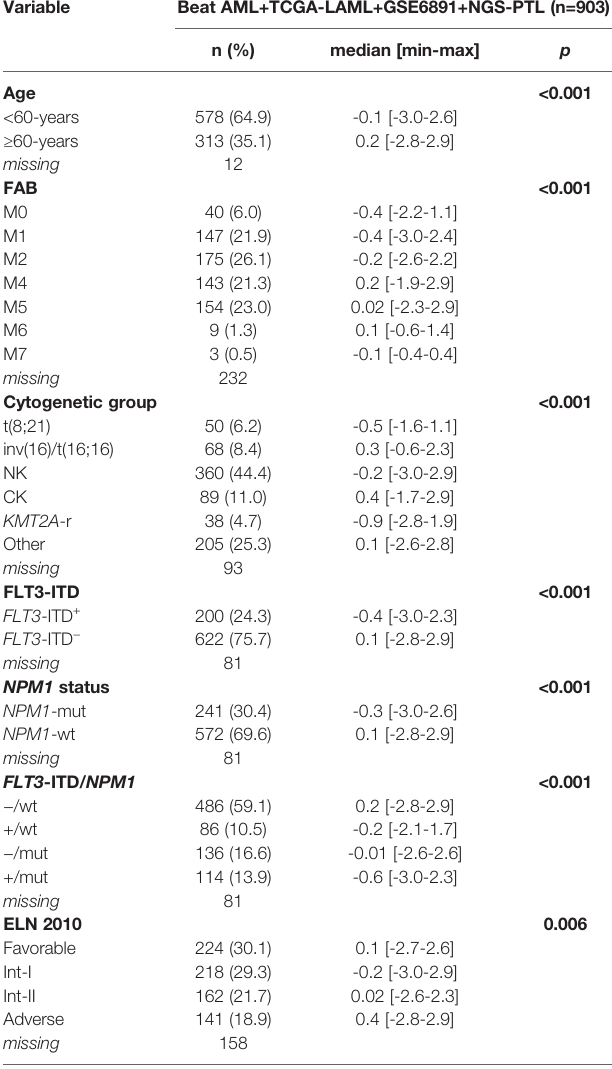
TABLE 2 | Association between ADM expression levels and clinical/molecular data in the overall AML cohort after normalization.